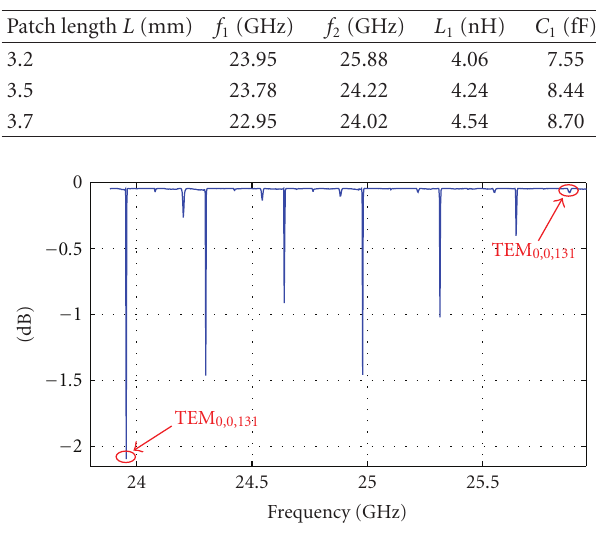
Figure 9: Measured return loss for the case L = 3 .